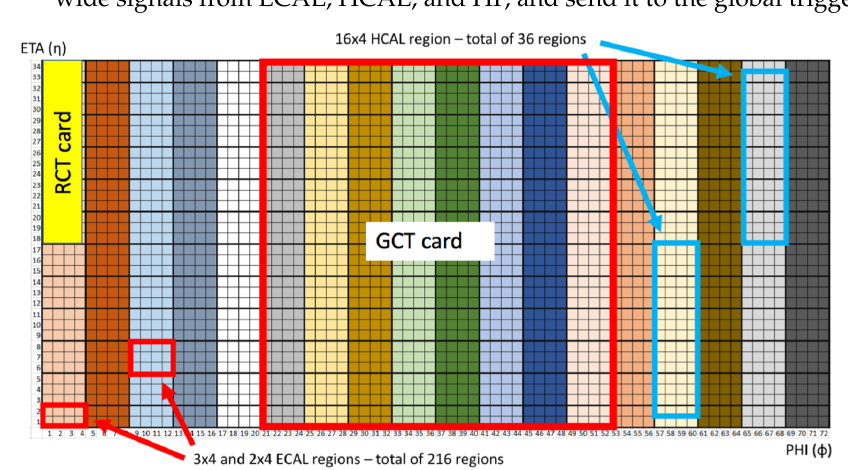
Figure 3. CMS barrel calorimeter segmentation. The x - axis represents the integer azimuthal angle (each integer represents 5 degrees in φ ). The y - axis represents the integer η or pseudorapidity (derived from the polar angle of the LHC coordinate system) [6]. This region represents the ECAL (34 η × 72 φ ) and HCAL (32 η × 72 φ ) barrel geometry. Each small square represents one tower of HCAL and ECAL. For ECAL, one tower represents 25 ECAL crystal. The geometry of 17 η × 4 φ is the processing region for one RCT